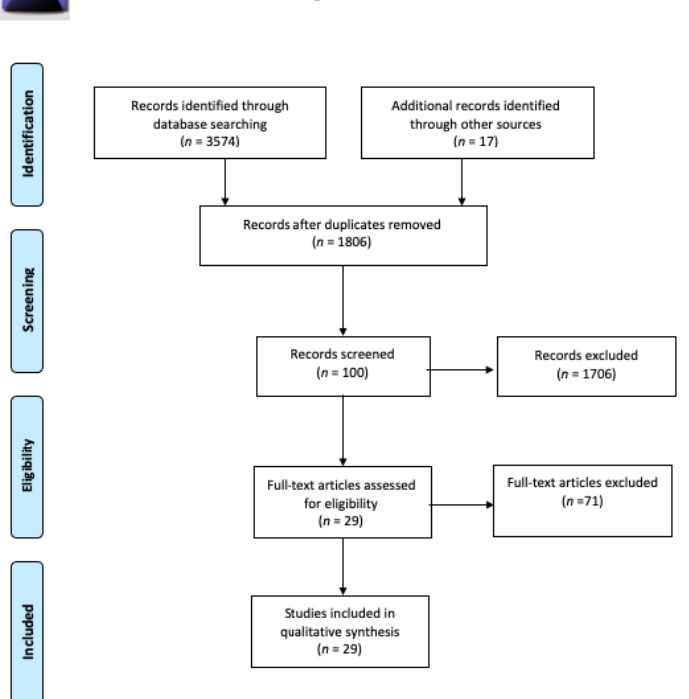
Figure 1. Preferred Reporting Items for Systematic Reviews and Meta-Analysis (PRISMA) flow diagram. Table 1. Studies characteristics and quality